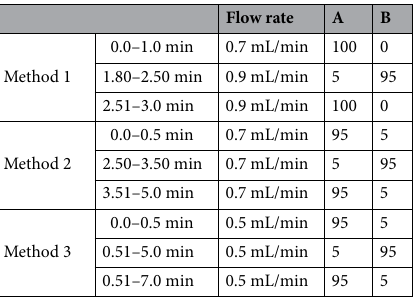
Table 5. LC phase flow methods tested to resolve separation challenges.